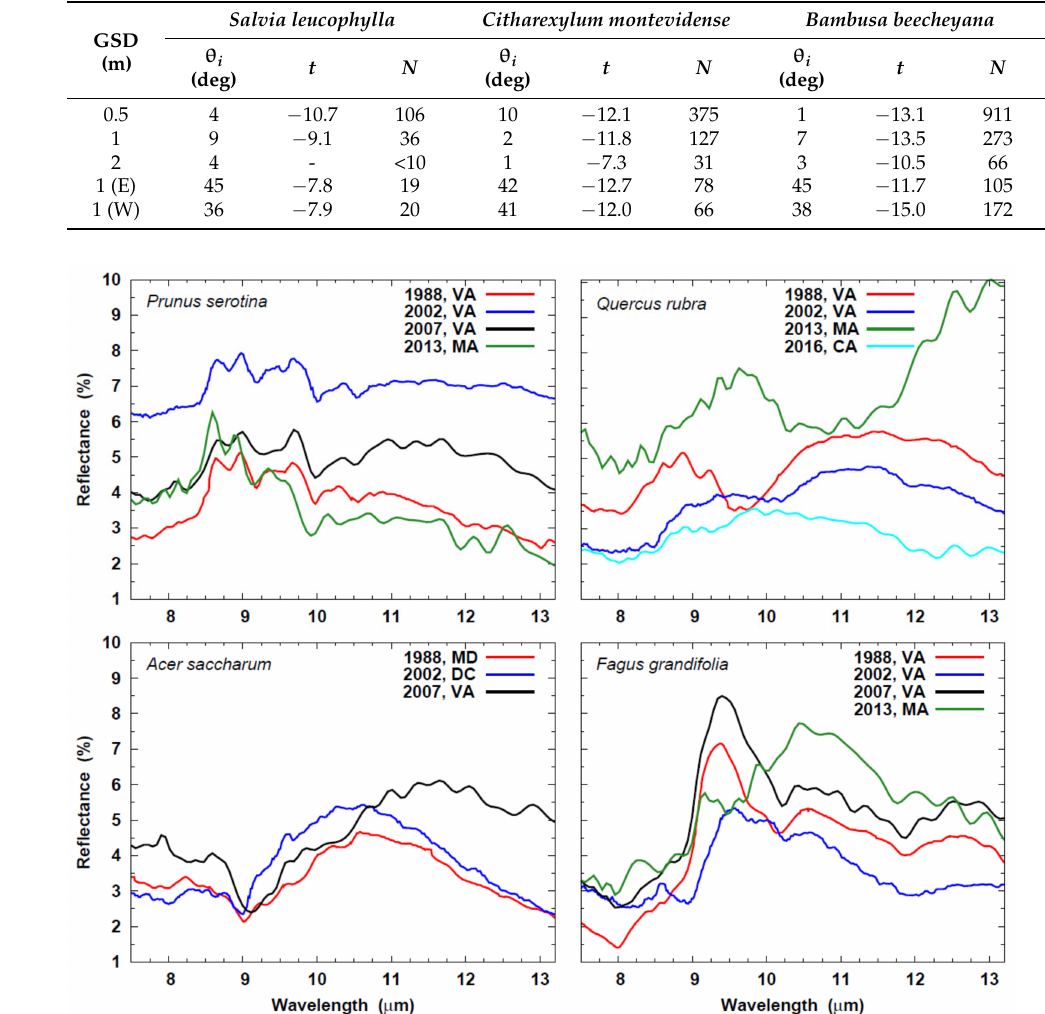
Table 3. Observational parameters corresponding to Figures 4–6.